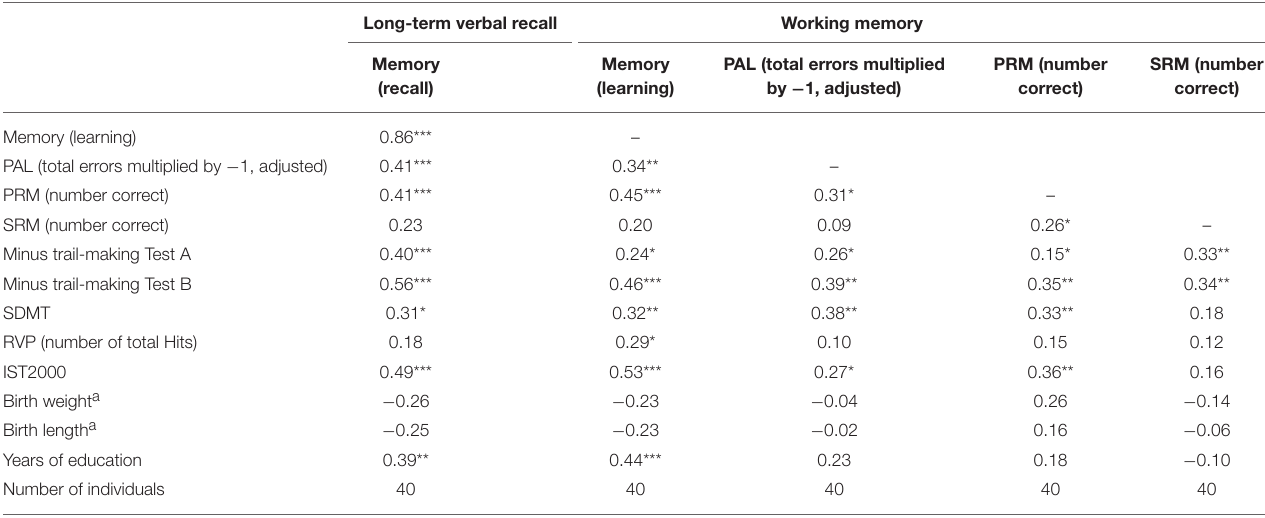
TABLE 5 | Pearson correlations between different memory scores and speed of processing, visual attention, frontal executive function, intelligence score, years of education, and birth measures. Long-term verbal recall Working